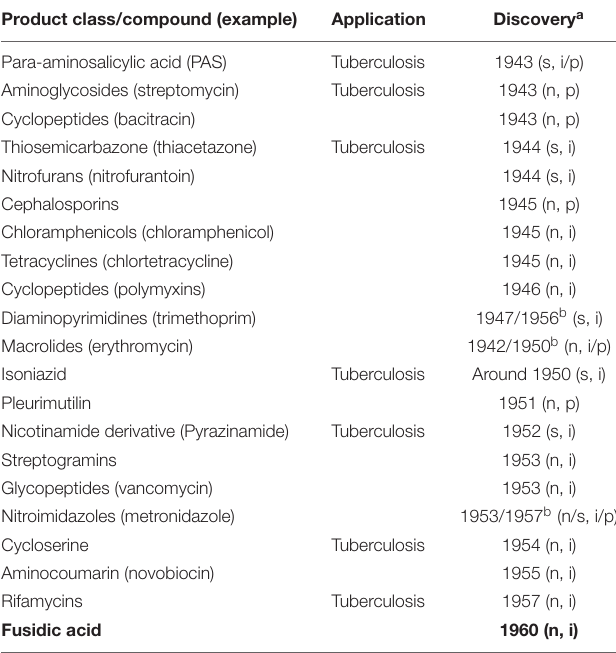
TABLE 1 | Discovery milestones of synthetic and natural product antibiotics 1943–1960, with indication of application toward